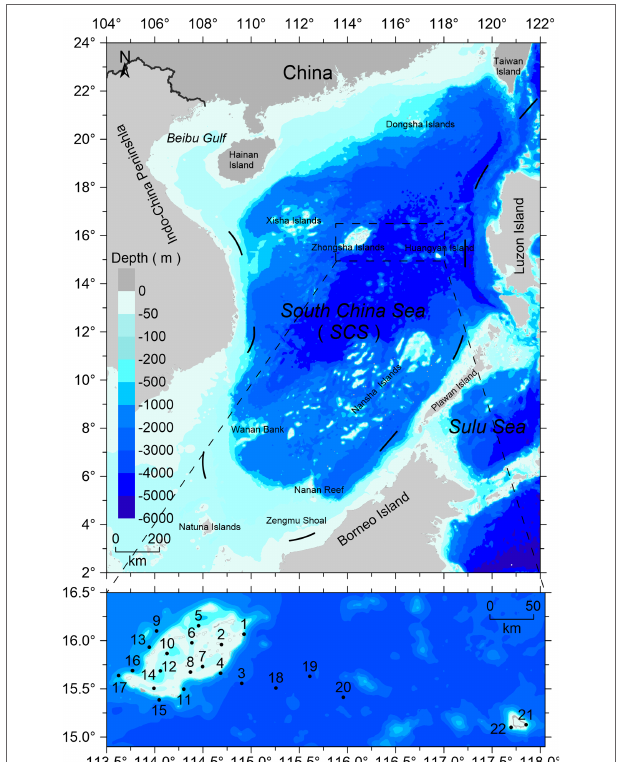
FIGURE 1 | Map showing the 22 sampling sites around the Zhongsha Islands, South China